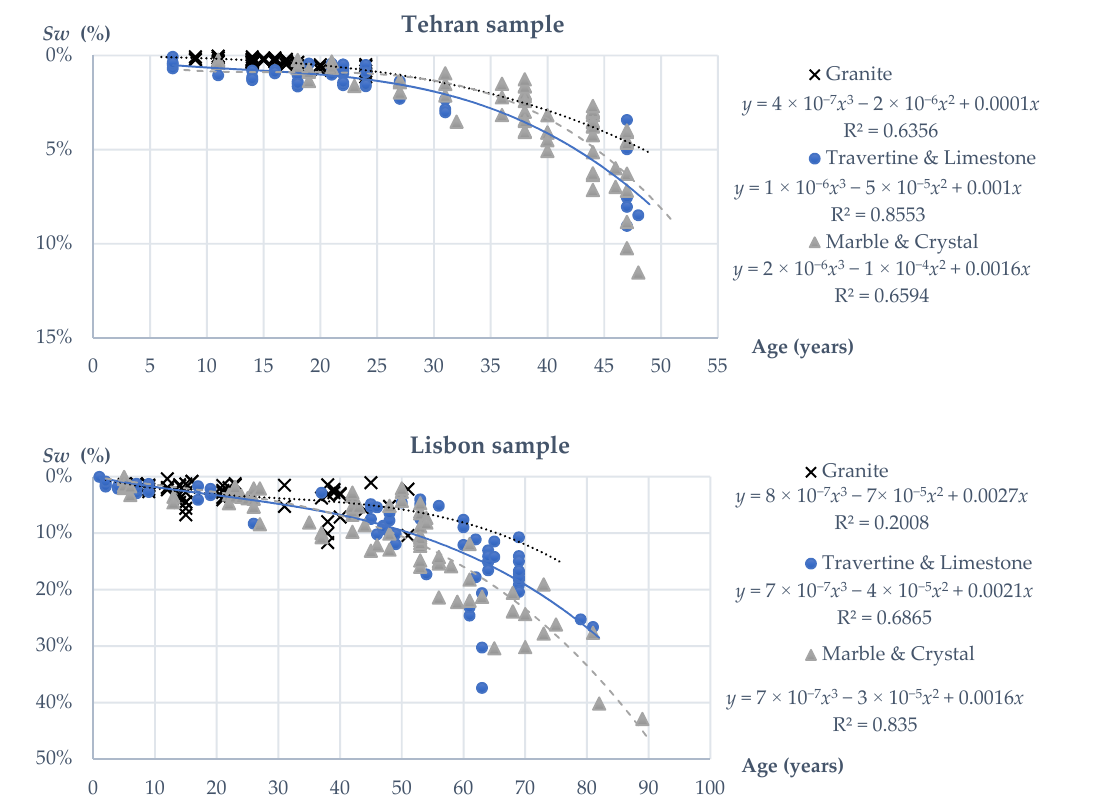
Figure 9. Degradation curves of the Tehran and Lisbon samples, according to the type of stone.